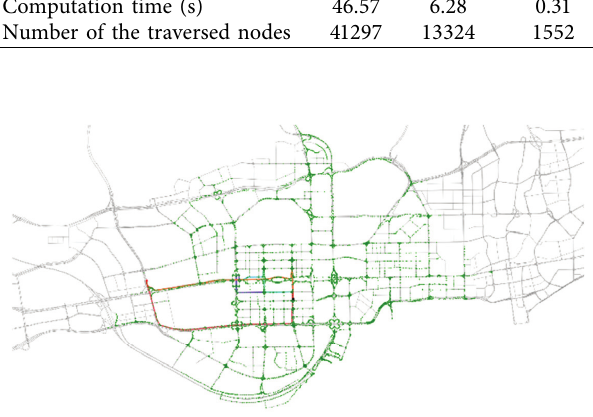
Figure 4: Charging path planning by